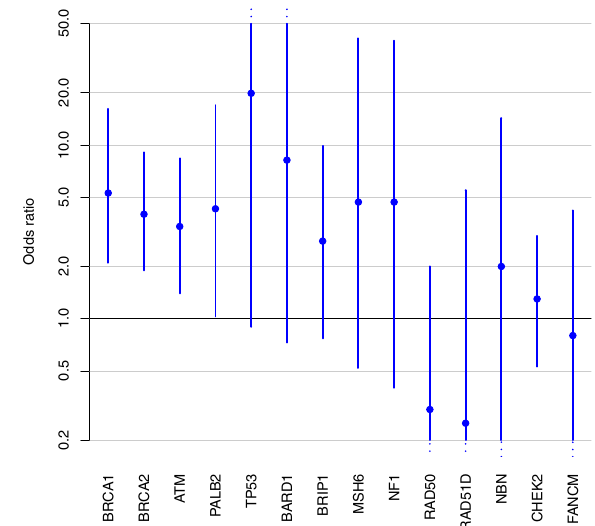
Fig. 2 Pathogenic variants and breast cancer risk. Adjusted odds ratios (large dots) and corresponding 95% con fi dence intervals (vertical lines) for the association between breast cancer and pathogenic variants in various genes, sorted by p